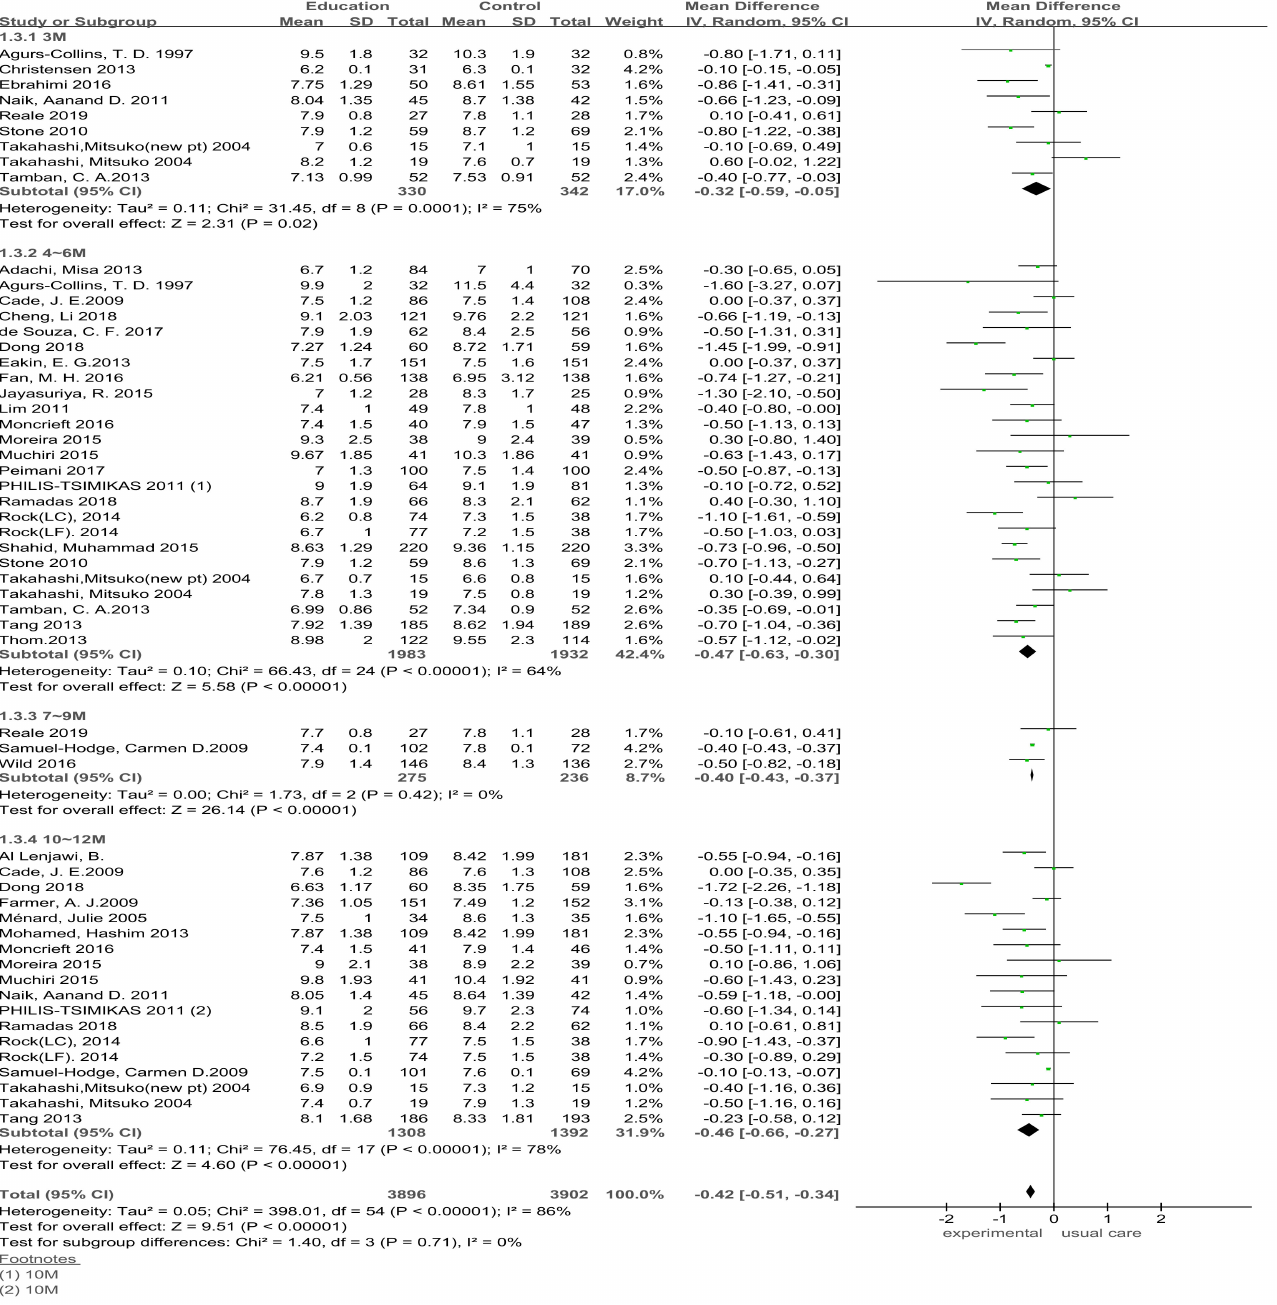
Figure 4. Follow-up effect of dietary education intervention on patients with type 2 diabetes. SD, standard deviation; CI, confidence interval; IV, inverse